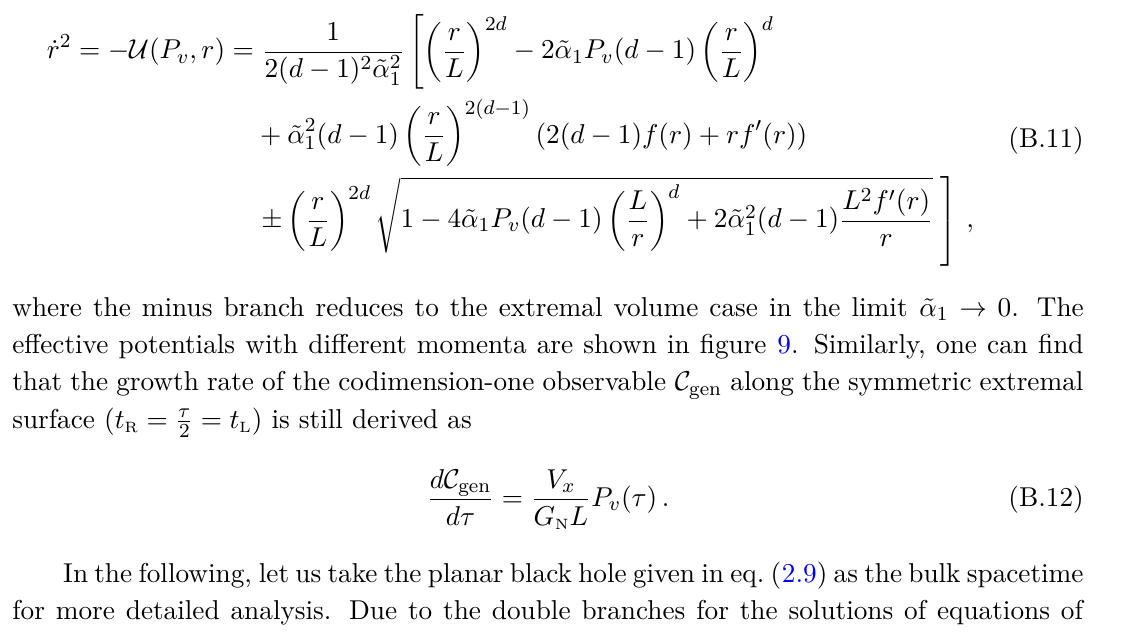
with the dimensionless parameter ˜ α